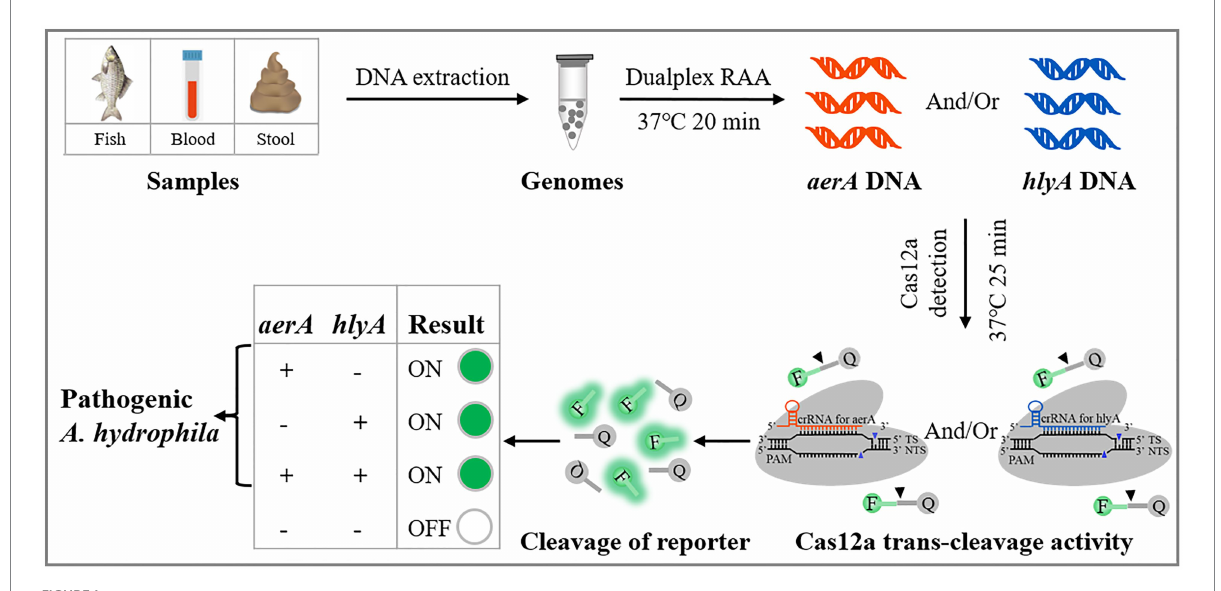
FIGURE 1 Schematic illustration of the developed dRAA-CRISPR/Cas12a method in the detection of pathogenic Aeromonas hydrophila